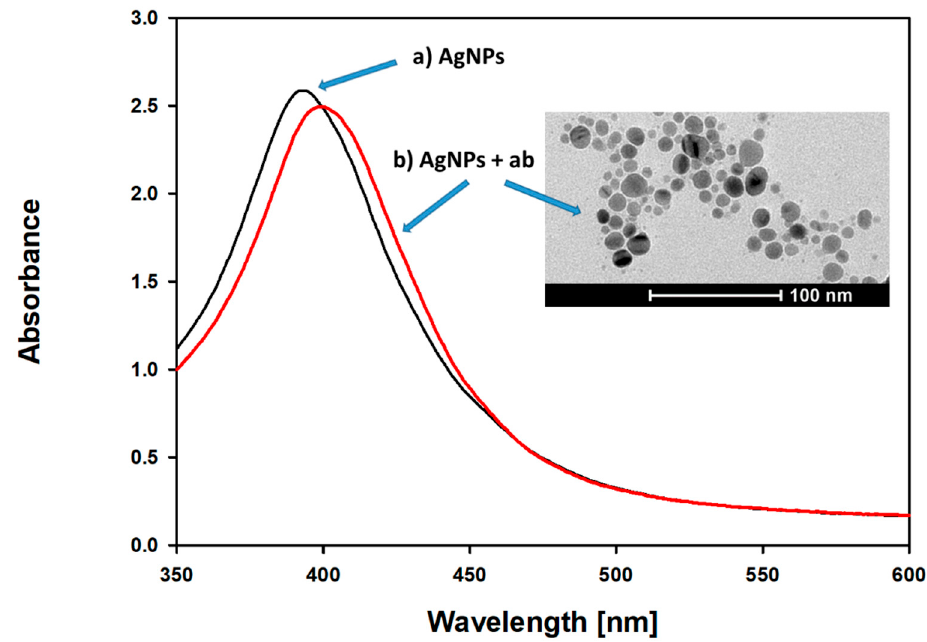
Figure 6. UV-Vis absorption spectra and TEM image: ( a ) silver nanoparticles (AgNPs) and ( b ) silver nanoparticles after coating with antibodies (AgNPs + ab). The TEM image highlights the protein corona surrounding the individual grains of nanoparticles.